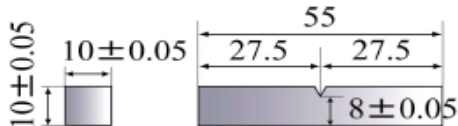
Figure 1. Shape and dimensions (in mm) of the measured samples. (Each sample had a V-notch at one face.). Table 1. Chemical compositions (wt%) of the investigated materials by optical emission spectroscopy.